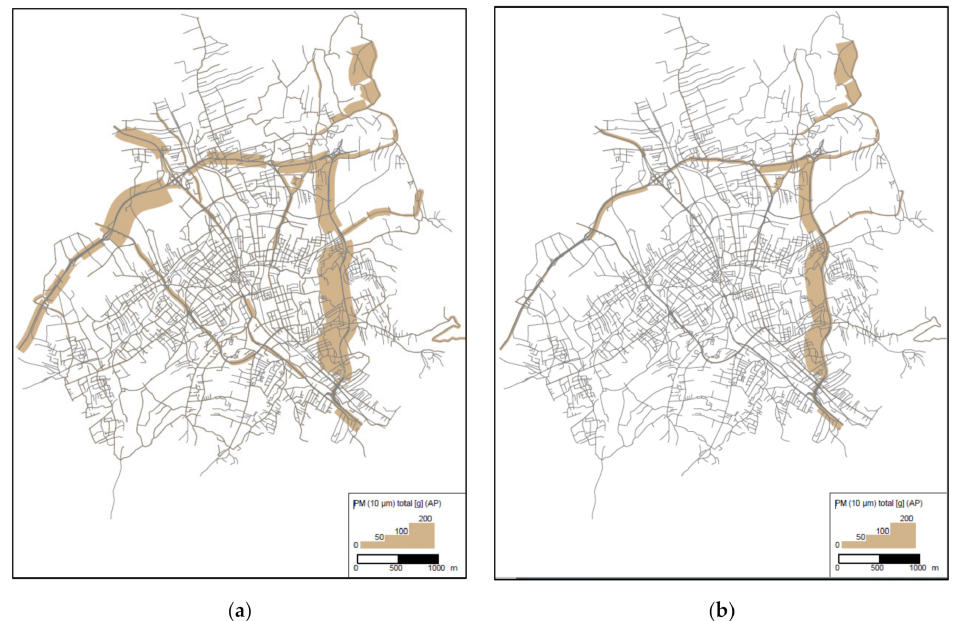
Figure 9. The assessment of particulate matter (PM) (10 µ m) total [g] (measure from Group 1) for scenario W0 and optimal scenario (W4)—analysis for the whole city: ( a ) measures for scenario W0; ( b ) measures for scenario